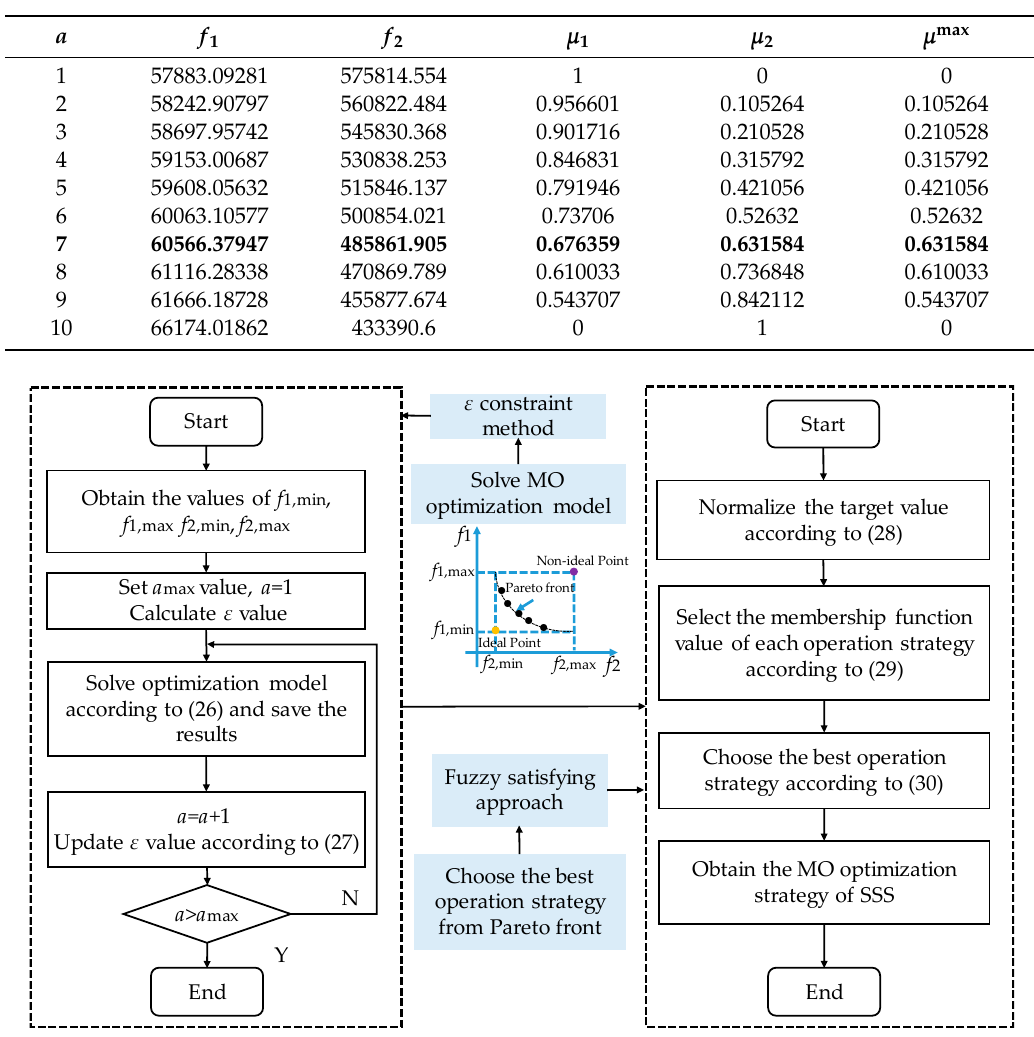
Table 1. An example of the fuzzy satisfying approach.